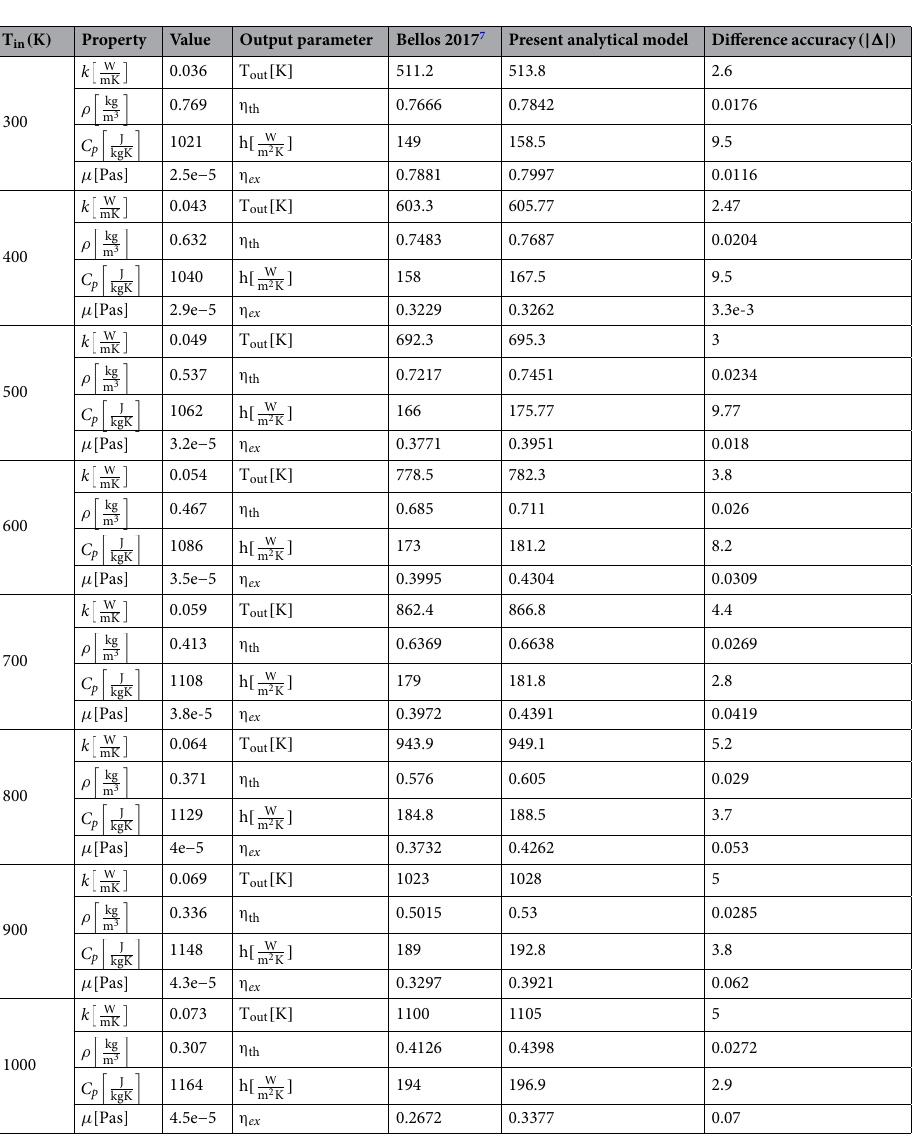
Table 3. Comparison with previous analyses from literature (for